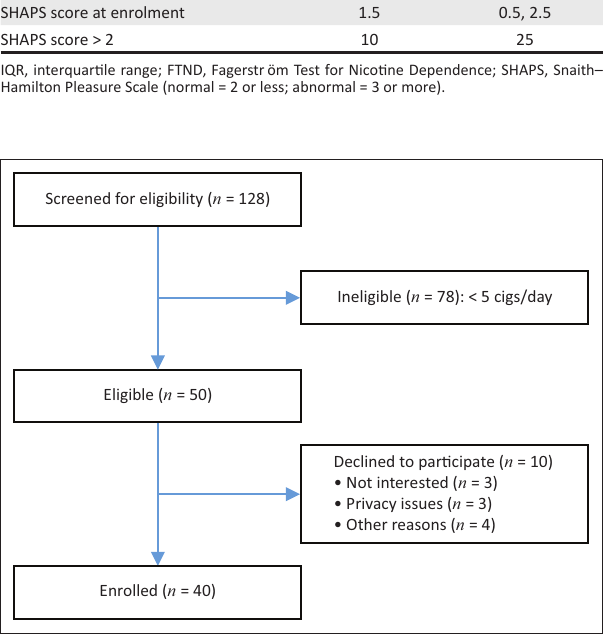
FIGURE 1: Participant flow